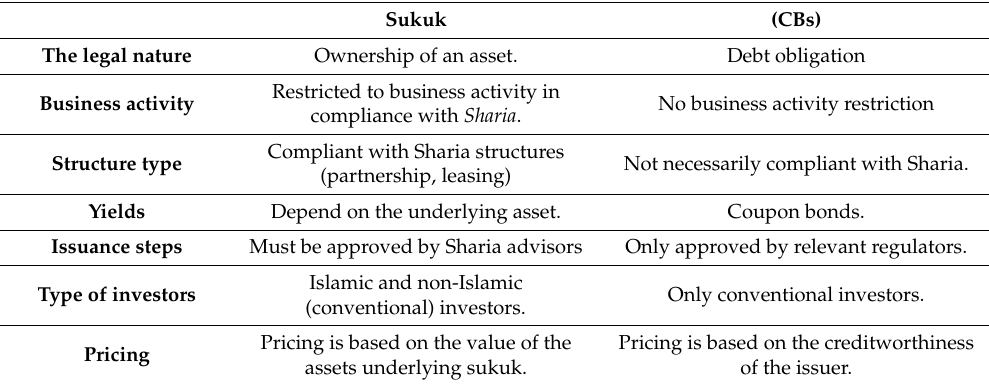
Table 1. Differences between sukuk and conventional